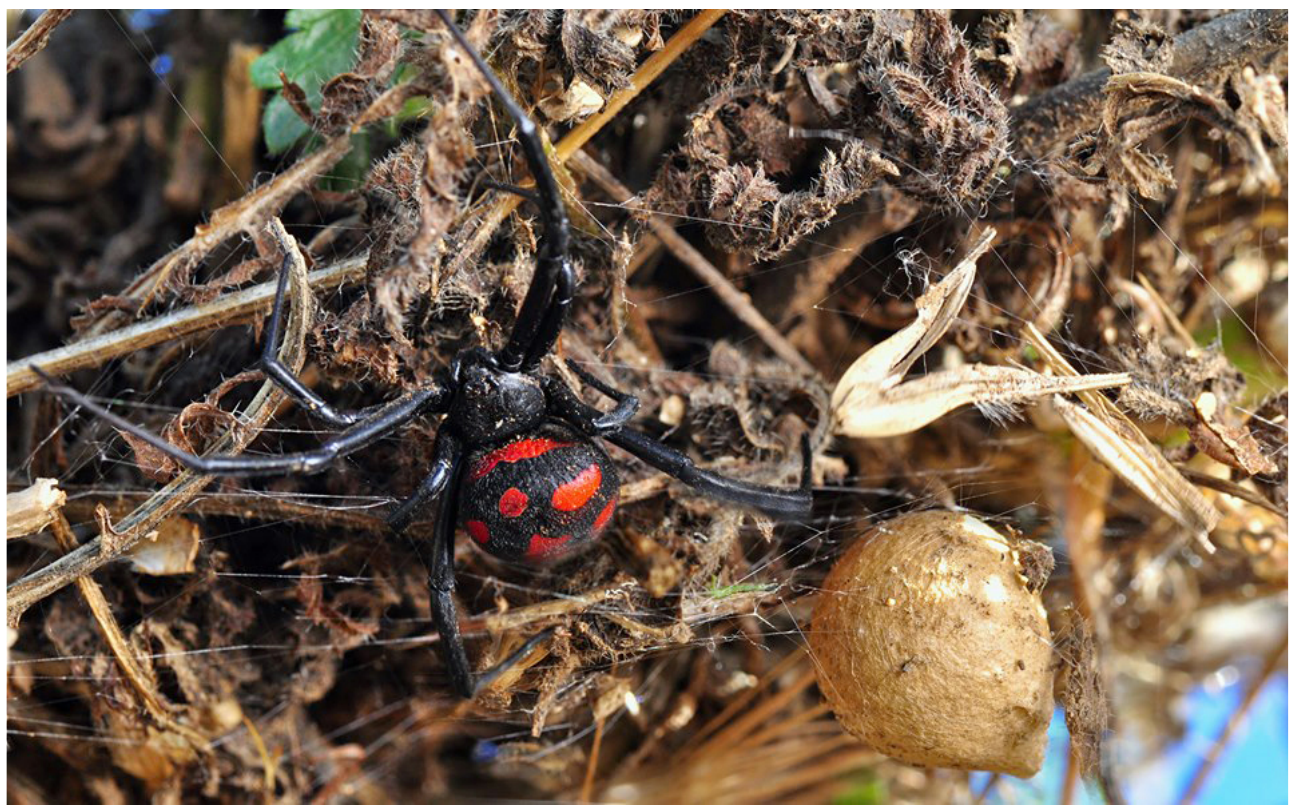
Figure 2. Latrodectus tredecimguttatus (photo courtesy of Pierluigi Rizzo).